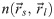
General schematic of topographic maps and coordinate system.Topographic order is established by retinal inputs to the superior colliculus (SC) and the lateral geniculate nucleus (LGN), as well as by LGN projections to visual cortex (V1), at the beggining of the second postnatal week (thick solid arrows). The nasal-temporal (N-T) axis of the retina is mapped along the posterior-anterior (P-A) axis of the SC and medial-lateral (M-L) axis of V1. And, the dorsal-ventral (D-V) axis of the retina is mapped along the lateral-medial (L-M) axis of the SC and anterior-posterior (A-P) axis of V1. New corticocollicular projections (dashed thin arrow) are established during the second postnatal week. These inputs are modeled as a number of connections (n(r→s, r→l)) between axons originating from neurons located at r→l coordinate in V1 and dendrites of neurons at r→s coordinate in SC. Any location in the SC and V1 are described as vectors (r→s and r→l, correspondingly) in the same two-dimensional retinal Ω-space. Ω-space is constructed upon mapping in wild type mice and is normalized to unit size along both the N-T and D-V axes of the retina.